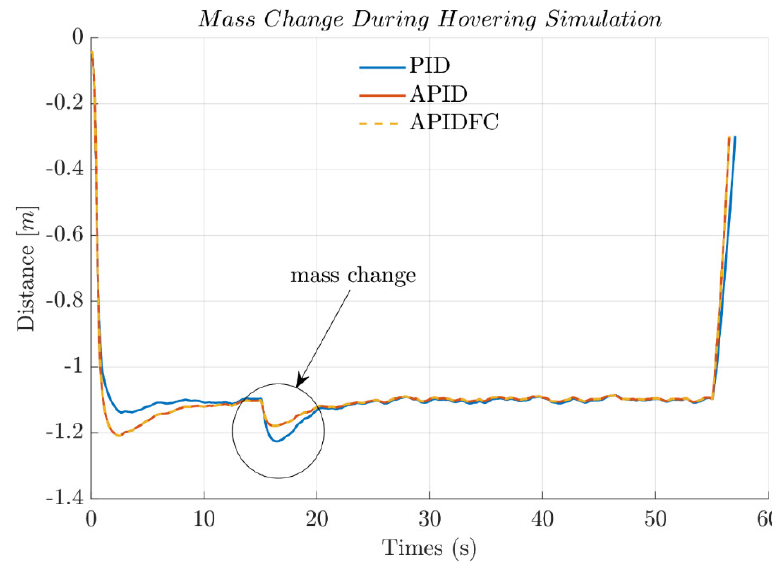
Figure 11. Changing mass during hovering in the simulation.